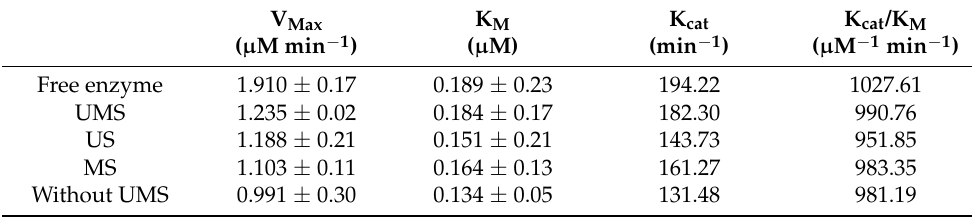
Table 1. Kinetic parameters of the free and immobilized enzymes prepared with and without UMS treatment.